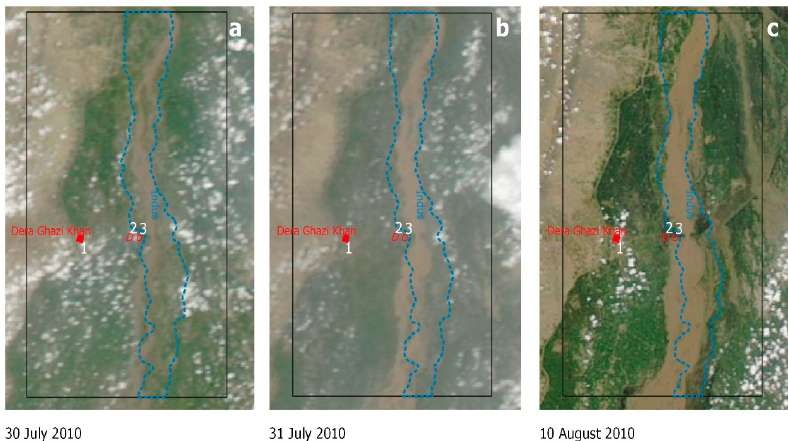
Figure 3. Images of the AOI obtained by the satellite MODIS during the flood event of summer 2010 [37], showing the progression of the water in three moments of the episode in which the clouds allowed to visualize the AOI: 30th ( a ) and 31st ( b ) of July and 10th of August 2010 ( c ). Blue dotted line represents the active floodplain in 1907. Many Satellite-derived products were produced to study this event [38–40]. The images show how the water occupies most of the early twentieth C.